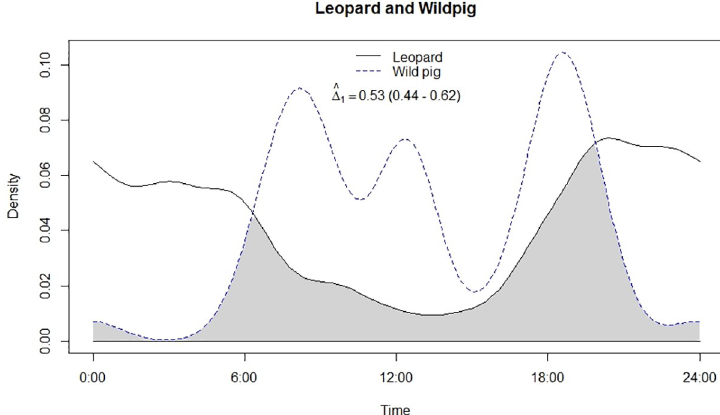
Fig 4. Temporal overlap between leopard and wild pig.